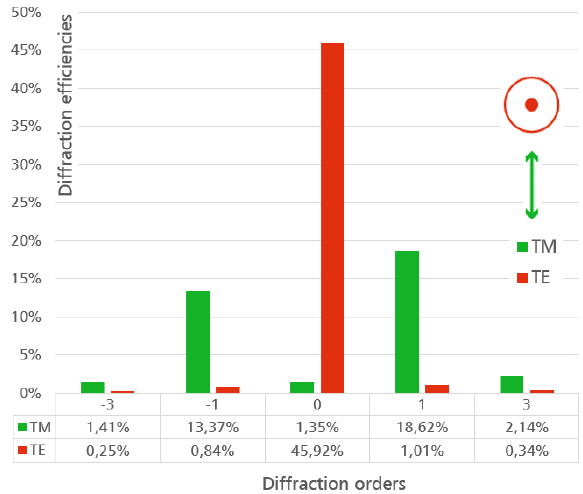
Figure 3. Di ff raction e ffi